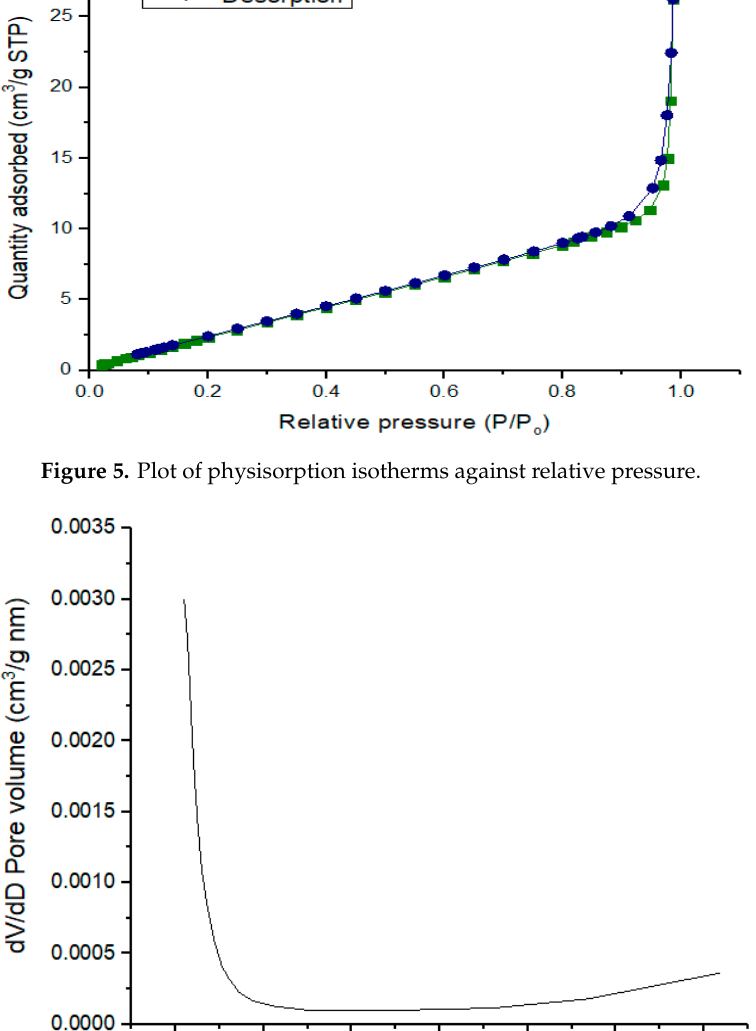
Figure 6. Pore size distribution of calcined CPK ash at 500 °C.